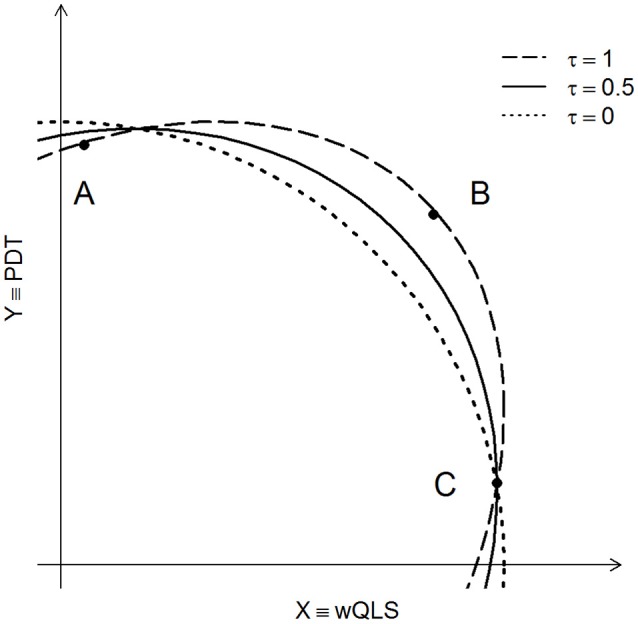
Three contours of constant probability are shown for POPFAM+. Dashed curve (τ = 1) is the density contour of the χ2 distribution with 2 degrees of freedom. The dotted line corresponds to τ = 0, and the solid line is the contour of constant probability for POPFAM+ when τ = 0.5. The X- and Y-axes are the values of (normalized) test statistics, with X representing the appropriately signed square root of wQLS, and Y representing PDT.